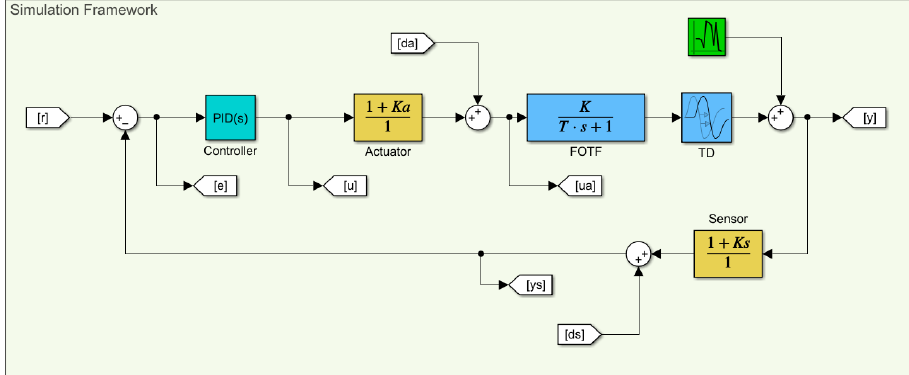
Figure 4. Simulation framework created in